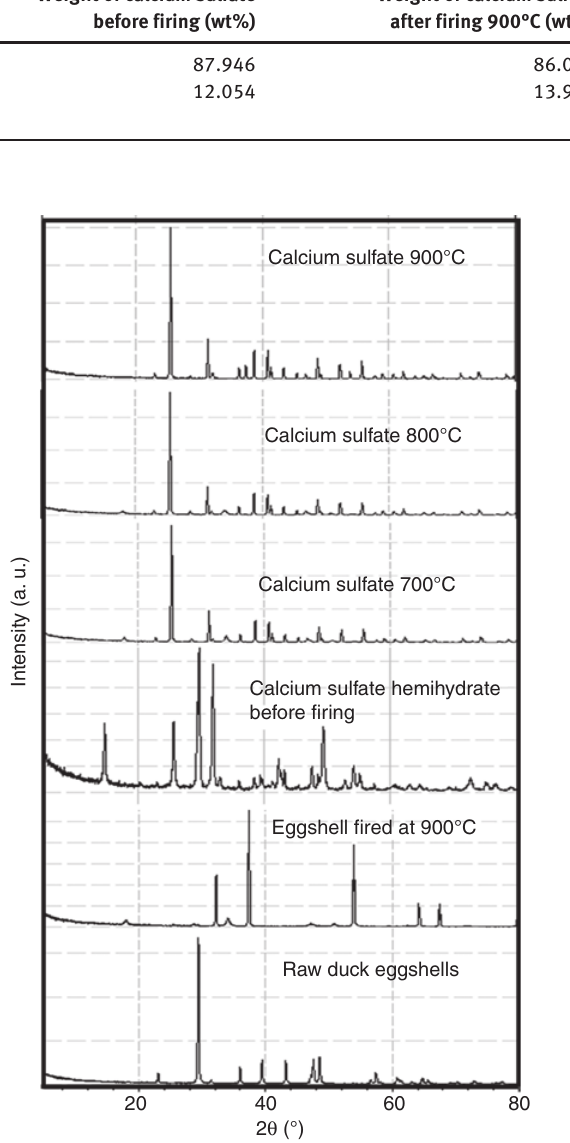
Figure 4: XRD peak patterns of the duck eggshell before and after calcination at 900 ° C for 2 h and calcium sulfate hemihydrate powders calcined at 700, 800 and 900 ° C, for 2 h,